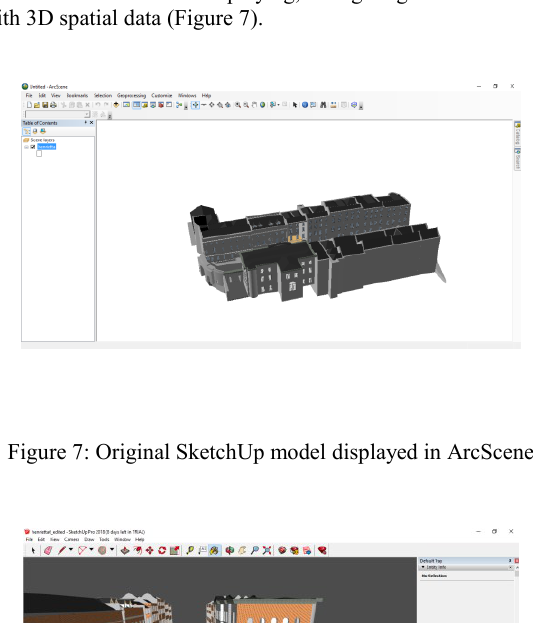
This 3D layer was then added into ArcScene, a 3D Viewer in ArcGIS which allows displaying, navigating and interacting with 3D spatial data (Figure 7).